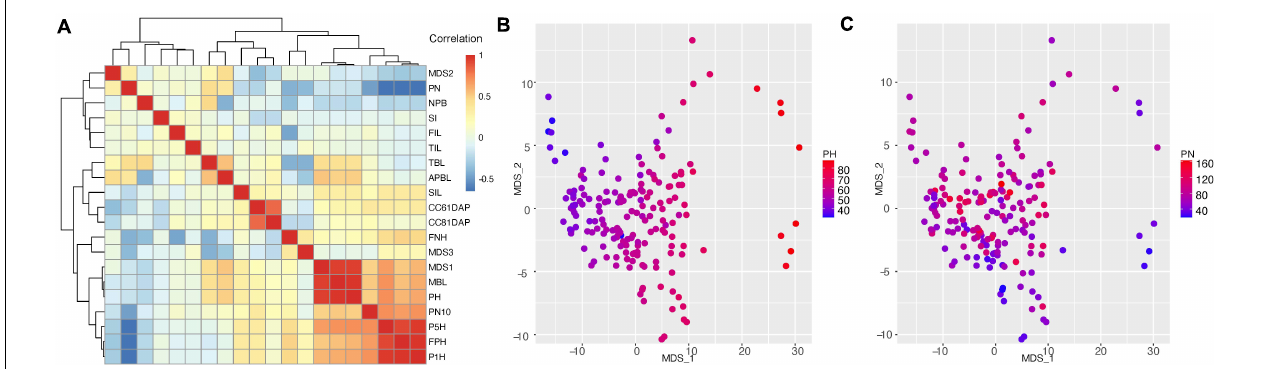
FIGURE 4 | Correlation analysis of traits characterized in this study. (A) correlation between edamame shoot architecture traits with topological traits (MDS1, 2, and 3). Trait names are described in Figure 2 and main text. PN, pod number; NPB, number of primary branches; SI, short internode; FIL, first internode length; SIL, second internode length; TIL, third internode length; TBL, total branch length; APBL, average primary branch length; CC61DAP, canopy cover 61 days after planting; CC81DAP, canopy cover 81 days after planting; FNH, first node height; MBL, main branch length; PH, plant height; PN10, pod number above 10 cm from ground; P5H, height above ground for 5% pods; P1H, height above ground for 1% pods; FPH, first pod height. (B) Comparison of MDS1 and MDS2 with plant height. (C) Comparison of MDS1 and MDS2 with pod